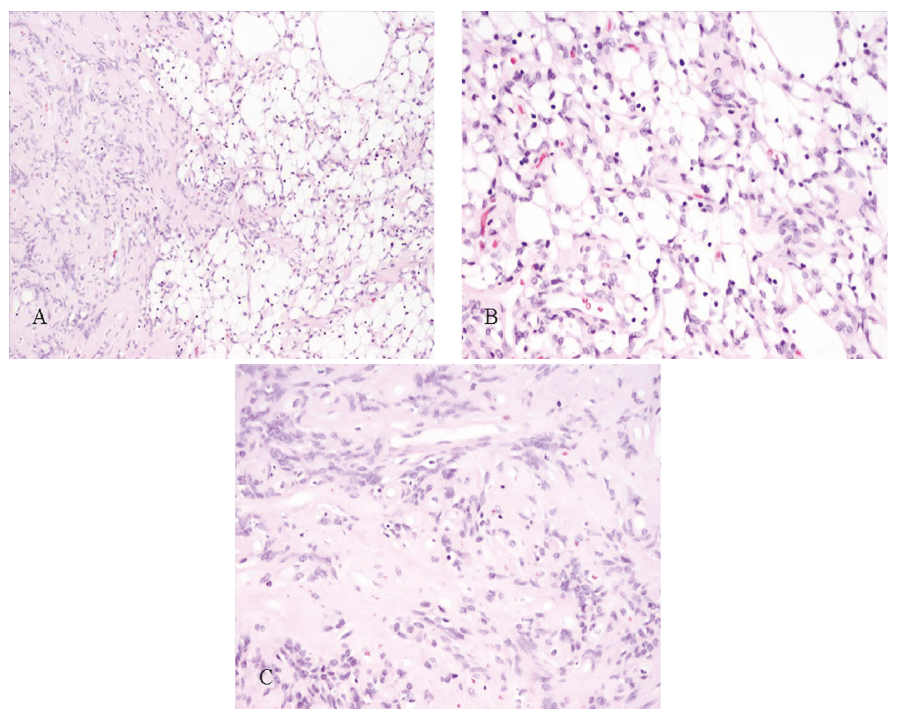
Figure 2: Photomicrographs of hematoxylin and eosin sections: (A) microcystic/reticular foci with a myxoid appearance adjacent to denser spindle cell areas (100x magnification); (B) microcystic areas with vacuolated cells; and (C) bland spindle cells with palisading configurations (B&C: 400x magnification).